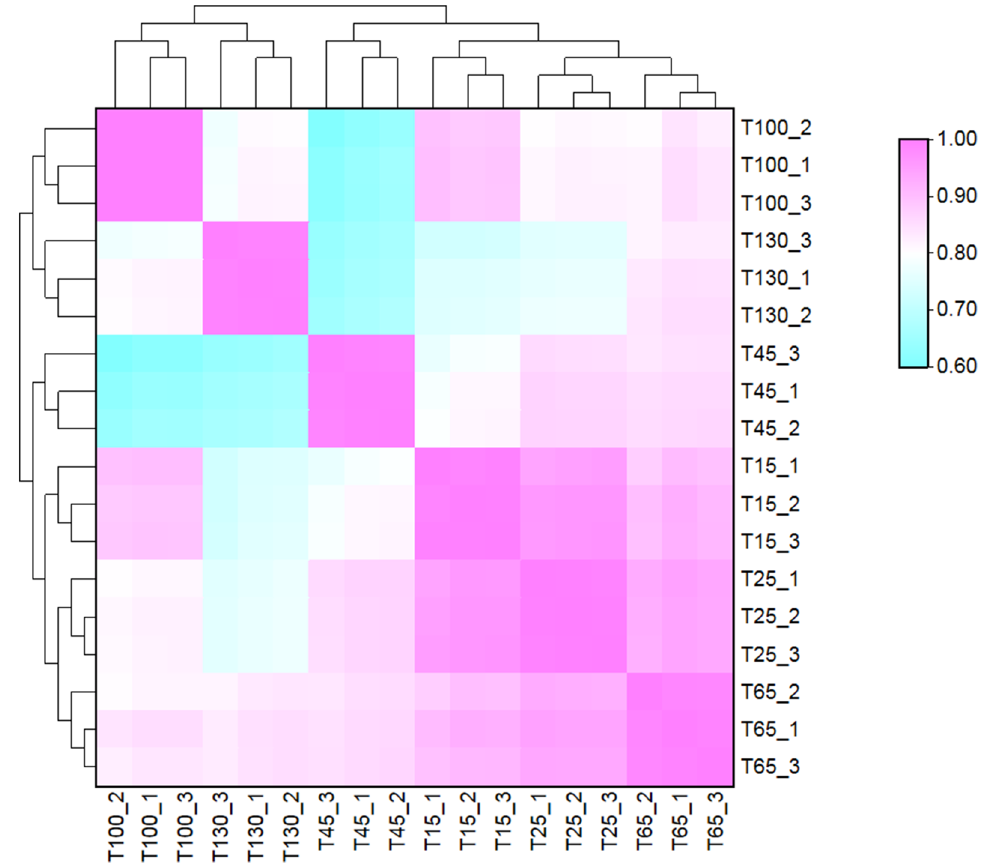
Figure 2. Pearson correlation analysis of sika deer antlers in 6 different development stages.